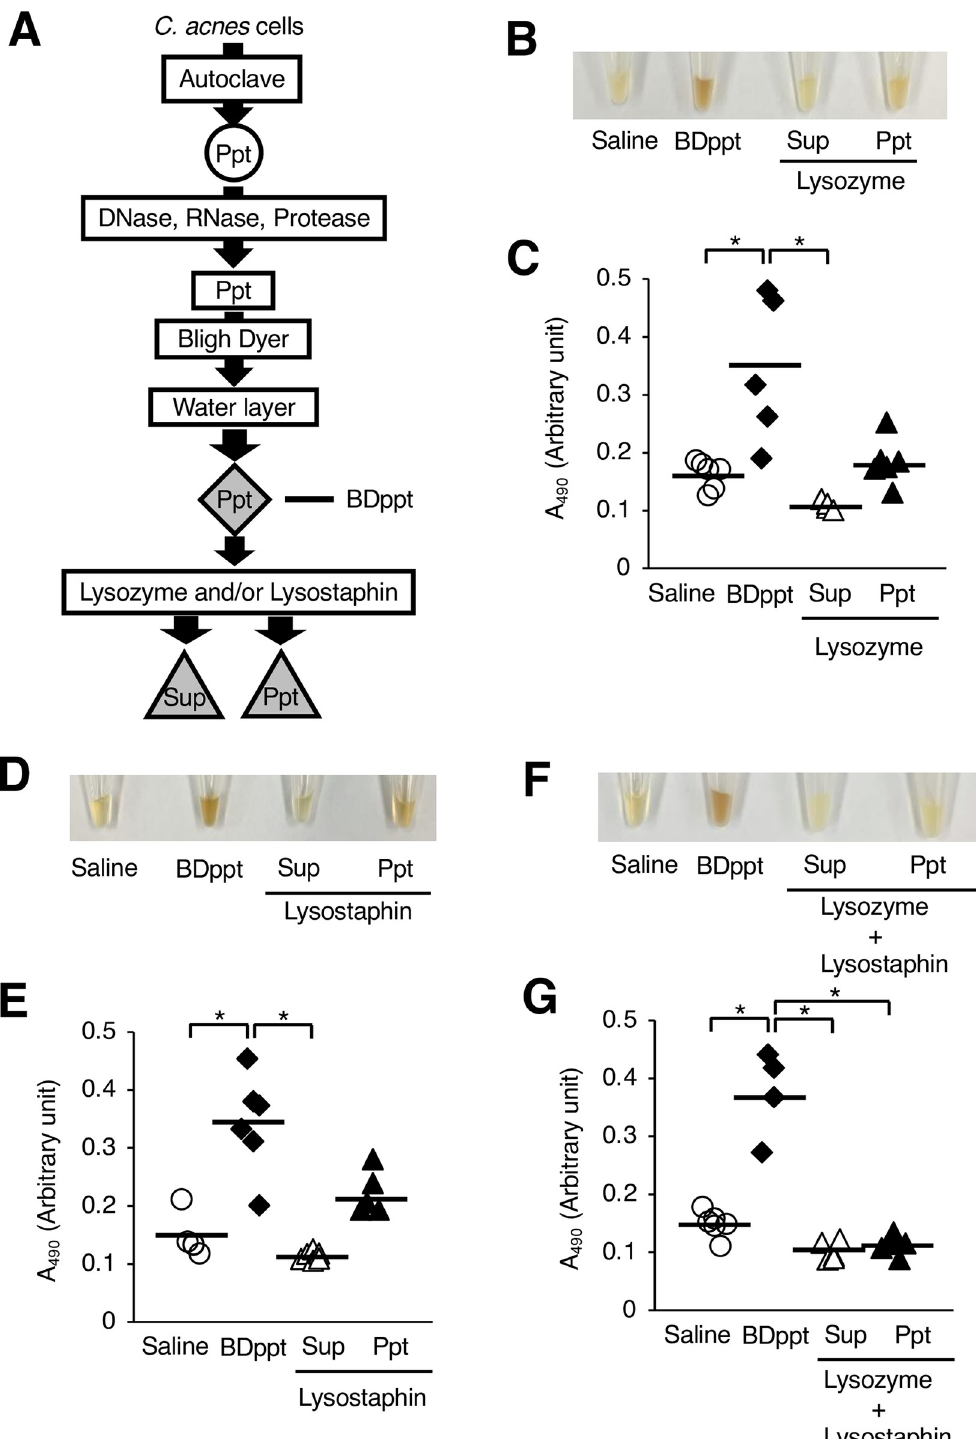
Fig 6. Reduction of melanization–inducing activity of the water–insoluble C . acnes fraction by treatment with peptidoglycan–degrading enzymes. ( A ) Preparation of the peptidoglycan–degrading enzyme–treated fractions. The water–insoluble fraction obtained following the Bligh–Dyer procedure was called the BDppt fraction. The BDppt fraction was treated with lysostaphin and/or lysozyme. Silkworms were injected with 50 μ l of saline (Saline), the BDppt fraction (BDppt), or the peptidoglycan–degrading enzyme–treated fractions. After incubation for 3 h at 37˚C, the